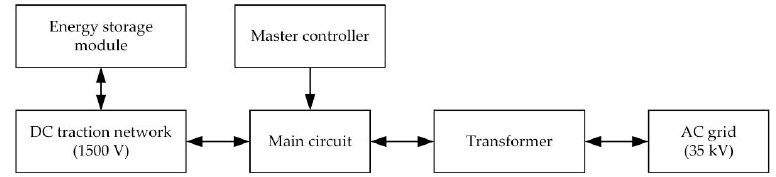
Figure 2. The diagram of the proposed RBE feedback system.